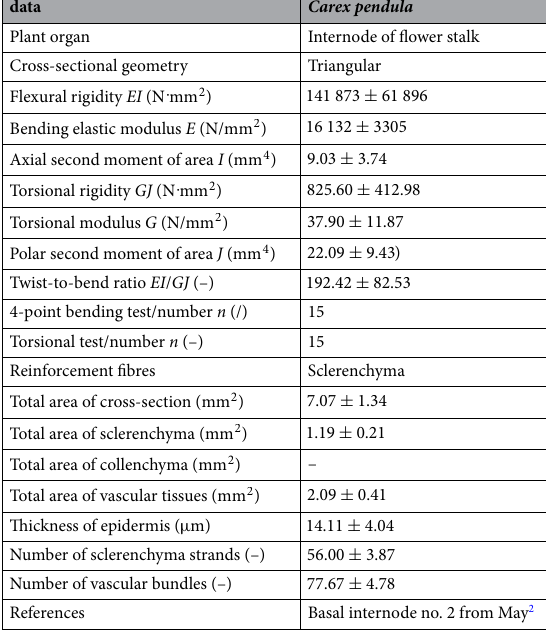
Table 1. Geometrical and mechanical properties of the flower stalk of Carex pendula . Mean values ± one standard deviation of the mechanical and geometrical properties of the entire internodes and the geometrical properties of individual tissues with reference to the cross-section are